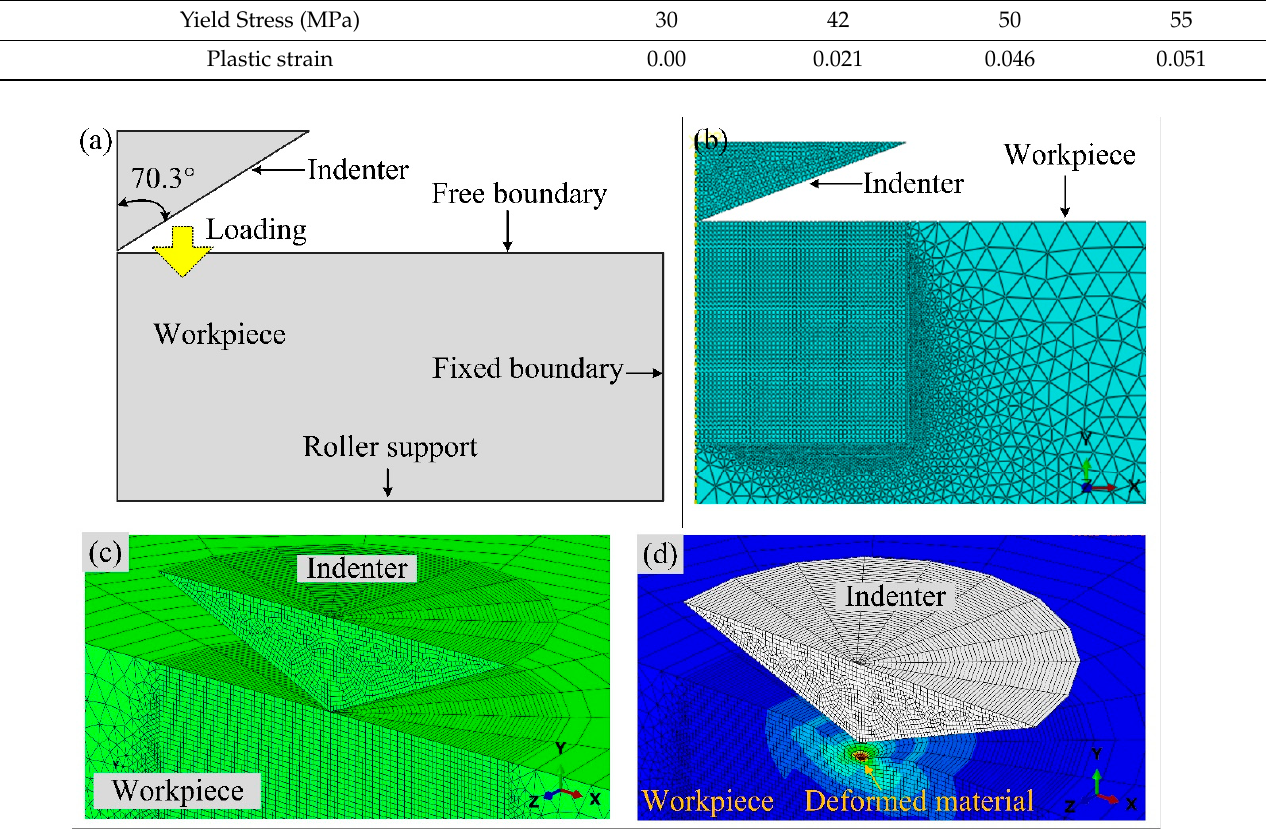
Figure 5. ( a ) Schematic representation of indenter and workpiece with boundary conditions, ( b ) axisymmetric mesh pattern, ( c ) 3D mesh pattern, and ( d ) deformed work material in 3D view.